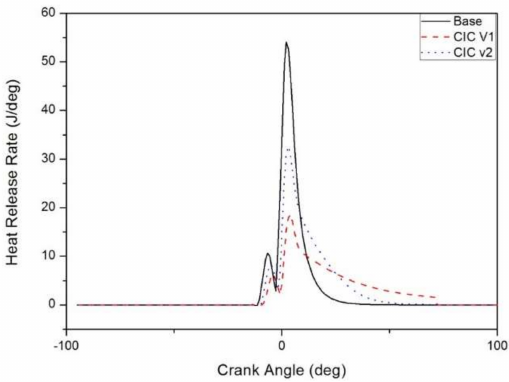
Figure 9. Heat Release Rate traces for three different recompression strategies.